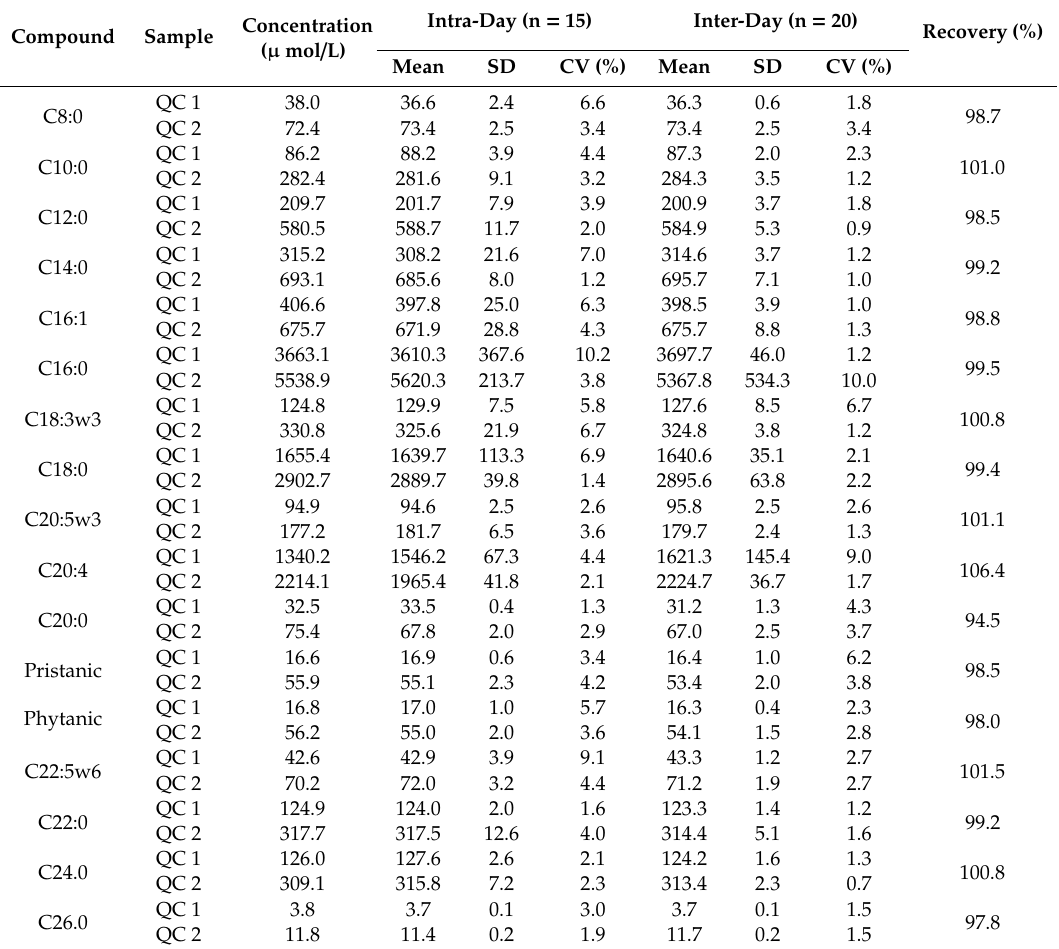
Table 2. Recovery, intra-day, and inter-day precision of FAs were analyzed by the current method. Compound